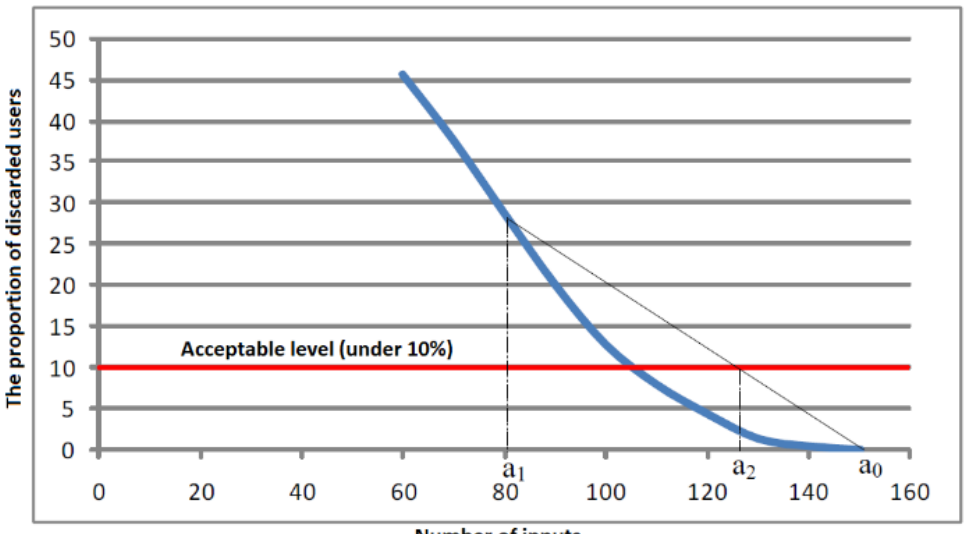
Figure 5. An example of the secant method application for optimization.